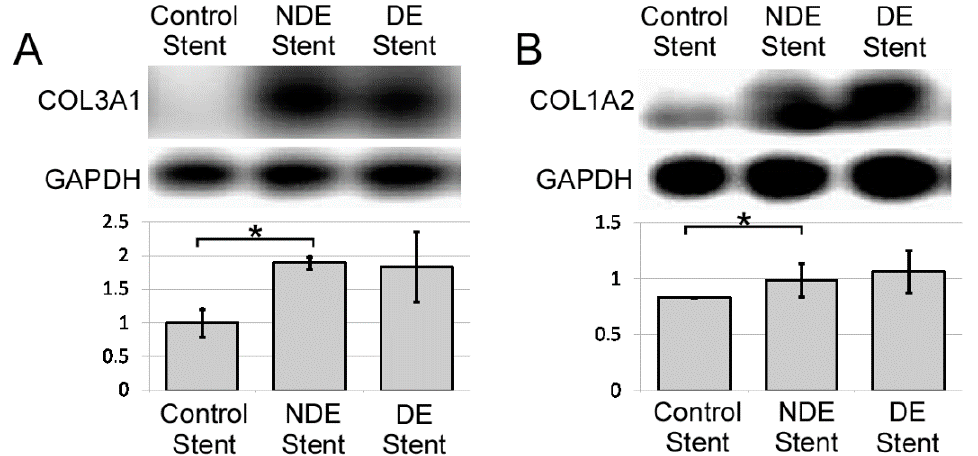
Figure 4. Western blot of collagen expression in ureteral protein extraction. Collagen subtypes, including ( A ). type III collagen, COL3A1, and ( B ). type I collagen, COL1A2, increased in thermally injured ureters. There was little difference in collagen expression between drug-eluting and non-eluting stents. However, the thermal injury did promote the expression of both subtypes. * p < 0.05 represents a significant difference for the NDE stent group compared with the control stent group.